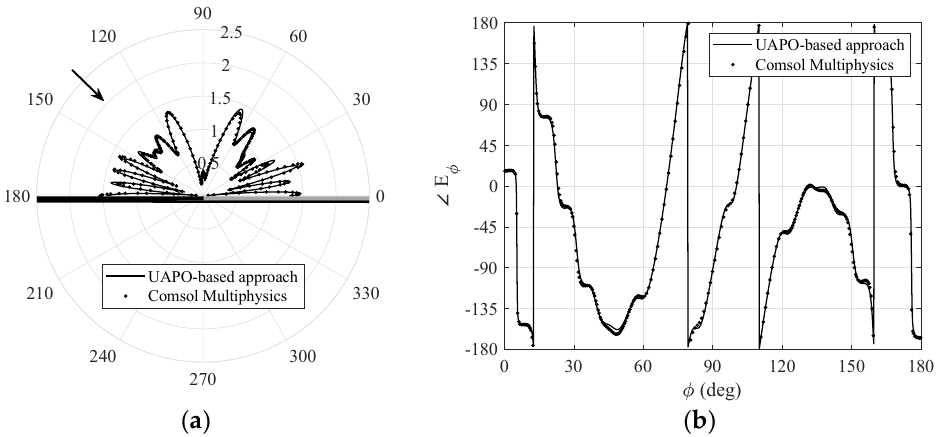
i = i = 0, E 1 . ( a ) i = 0, E i = 1 . ( a ) i = 0, E i = 1 . ( a ) = 0, E i = 1. b ' f ' φ (cid:48) β (cid:48) b ' f ' b ' f '